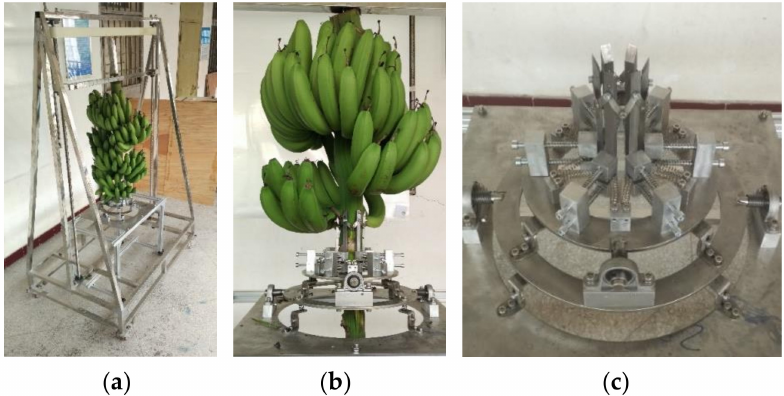
Figure 7. A self-adaptive banana de-handing device based on constant force mechanism: ( a ) overall diagram of the device; ( b ) banana de-handing procedure; and ( c ) the constant force mechanism of the